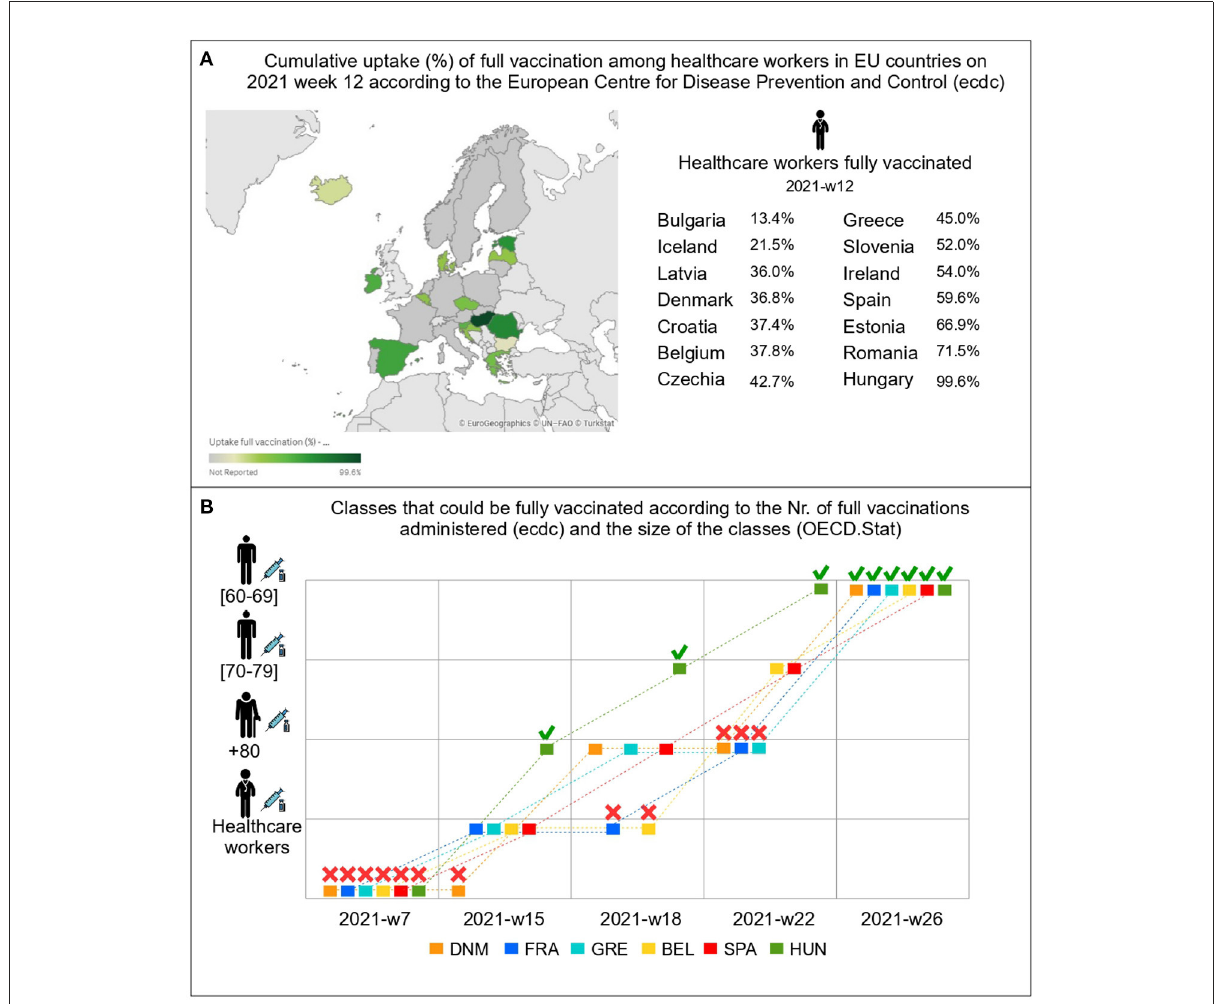
FIGURE1 Data and map from the European Center for Disease Prevention and Control (ecdc) and OECD.Stat. (A) shows a high dispersion in the vaccination rates of healthcare workers within the EU in week 12/2021, showing that Prioritizing According To Needs was violated. (B) uses OECD data (Table 1) and shows which priority classes could have been fully immunized at different points in time (2021) according to ecdc data on full vaccinations administered (primary course) in each territory. This exercise shows that Treating Equal People Equally was violated. For example, on week 22 nd , beyond the case of Hungary (which decided to buy vaccines from third countries on top of the agreement with the EU), we observe that Belgium and Spain could have started immunizing citizens from 60 to 69 years while France, Greece, or Denmark did not have enough vaccines to have immunized all citizens above 70 years. Icons made by Freepik from Flaticon